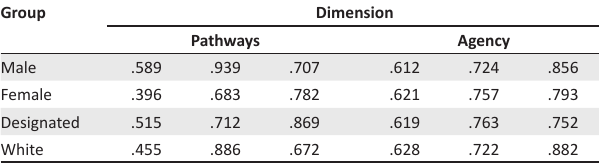
TABLE 1: Factor loadings of the hope dimensions.